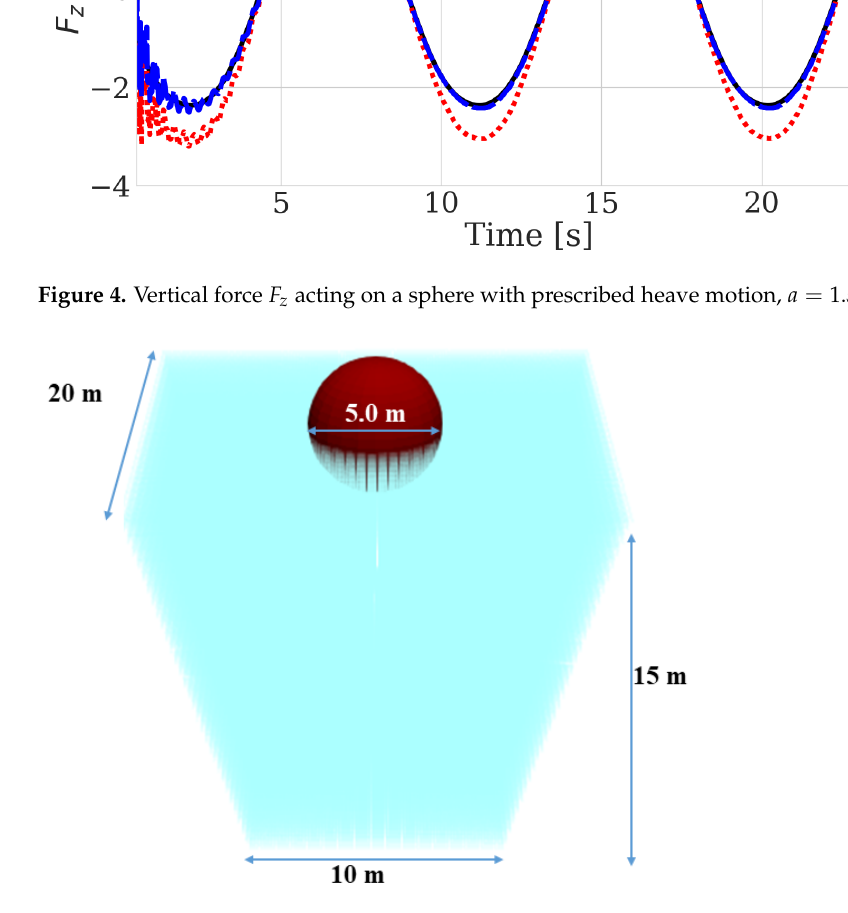
Figure 4. Dimensions of the numerical wave basin for hydrodynamic coefficients and drag coefficient test for a heaving sphere.